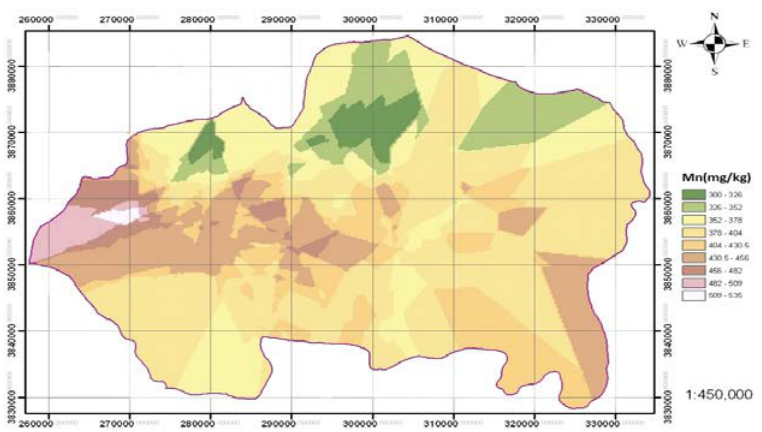
Fig. 5: Spatial distribution of manganese in the soils of Hamedan region